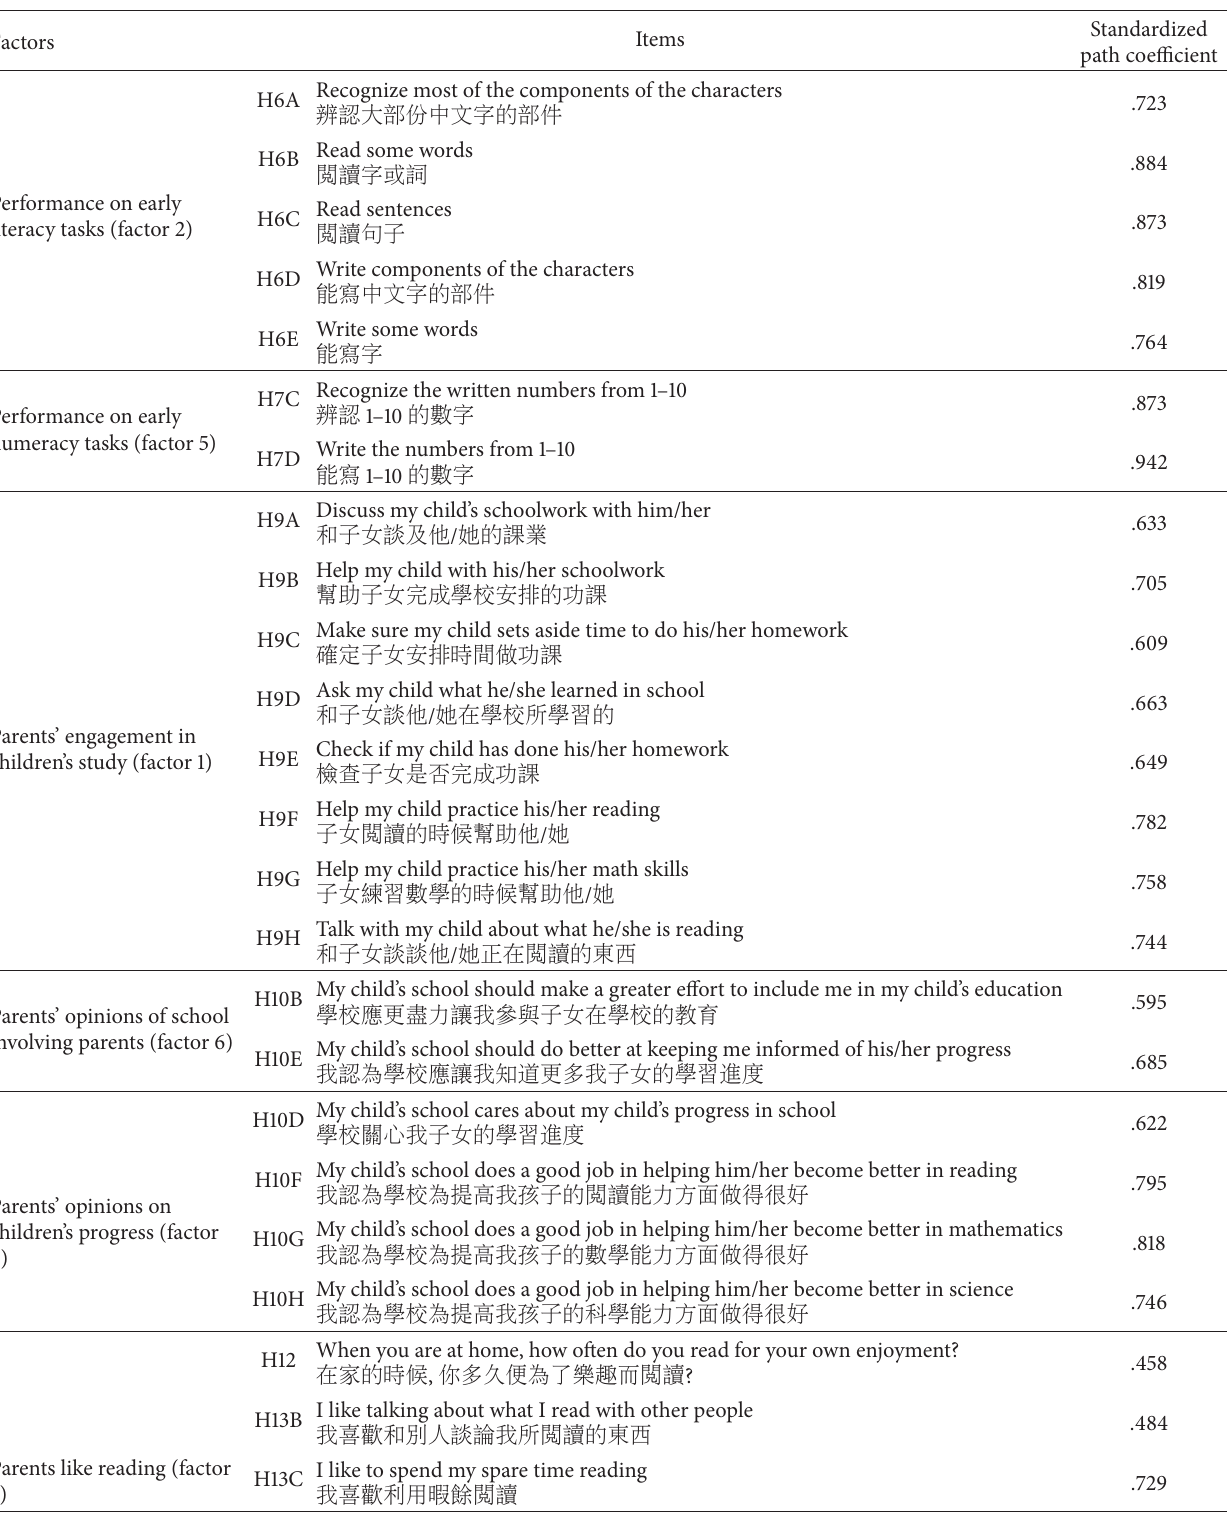
Table 4: Confirmatory factor analysis with standardized path